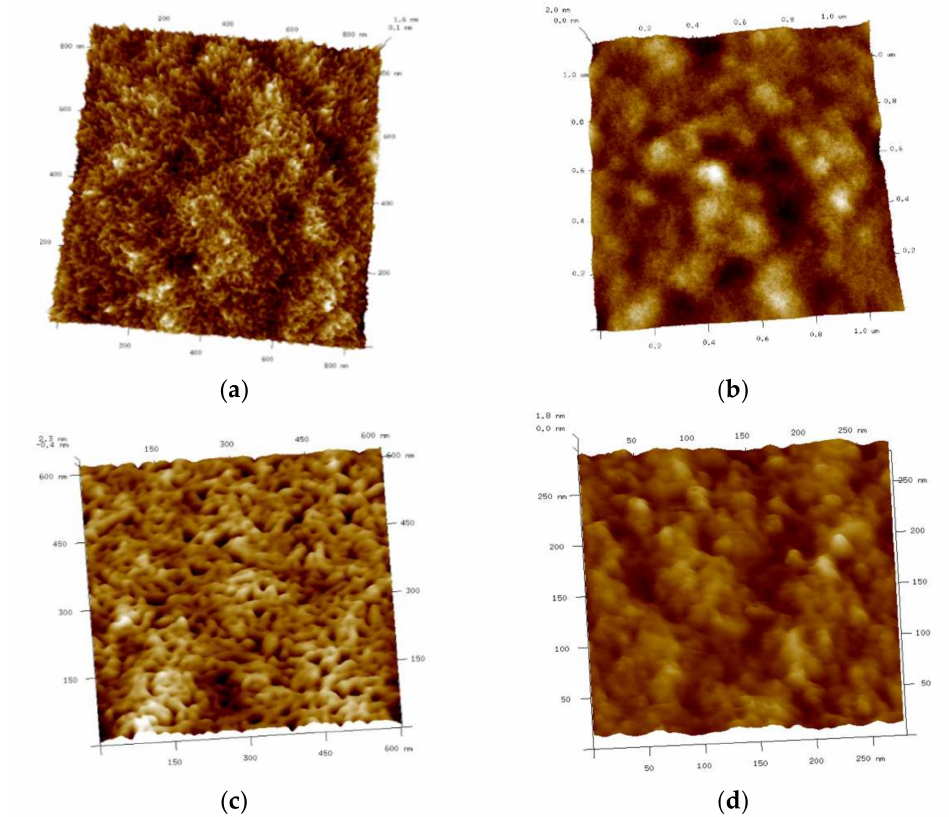
Figure 16. AFM images 3D of shark gelatin hydrogel.; ( a ) Zone 1 with a field of view of 1.6nm; ( b ) Zone 2 with a field of View 2nm; ( c ) GE/5IL with a field of view 600 × 600nm 2 ; ( d ) GE/25IL field of view 260 × 260nm 2